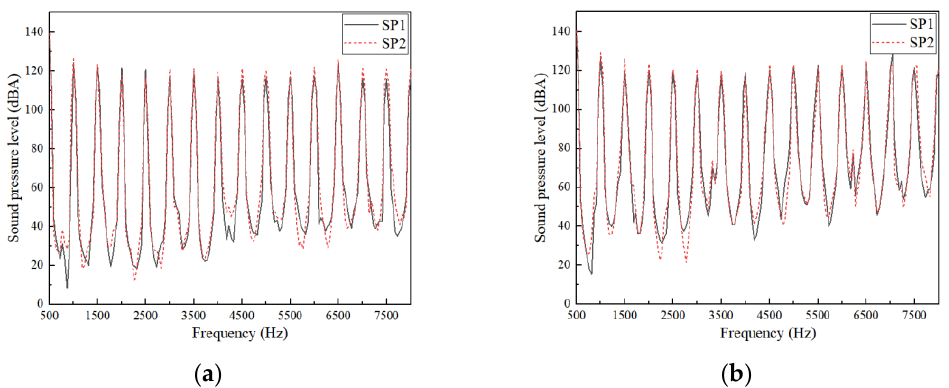
Figure 15. Near-field aerodynamic noise characteristics of air compressor at idle condition. ( a ) First stage. ( b ) Second stage.